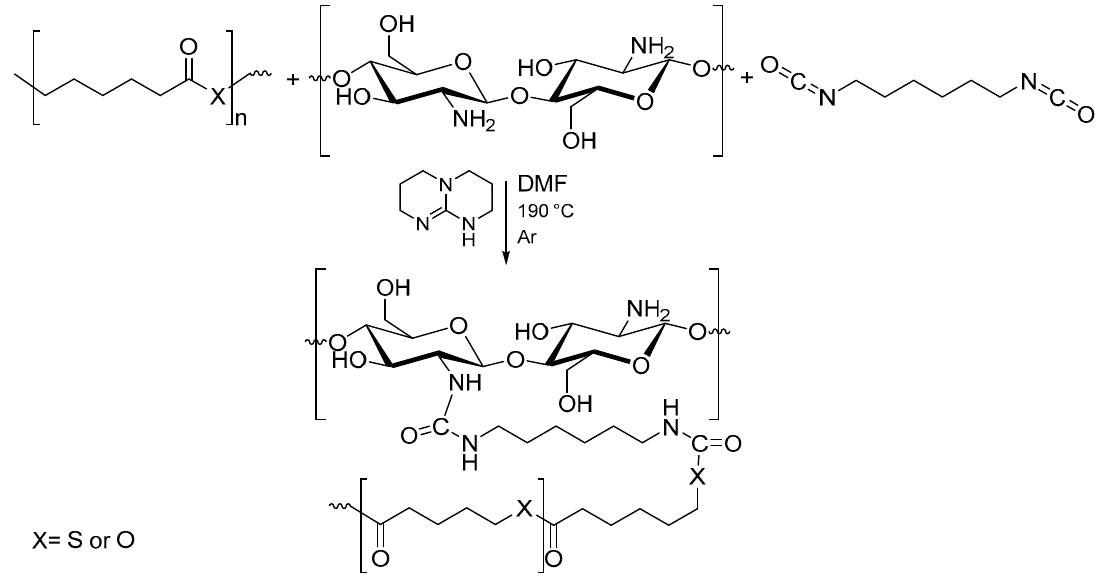
Scheme 4. Reaction of polyester chains grafting onto the chitosan